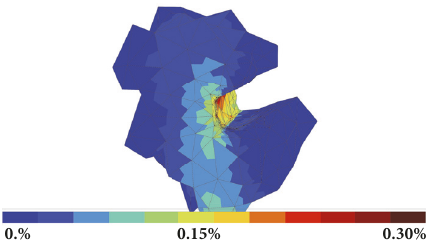
‖𝜎(𝑦, 𝑉 𝐻 𝛾 𝐻 )‖ × 100 in 𝑅